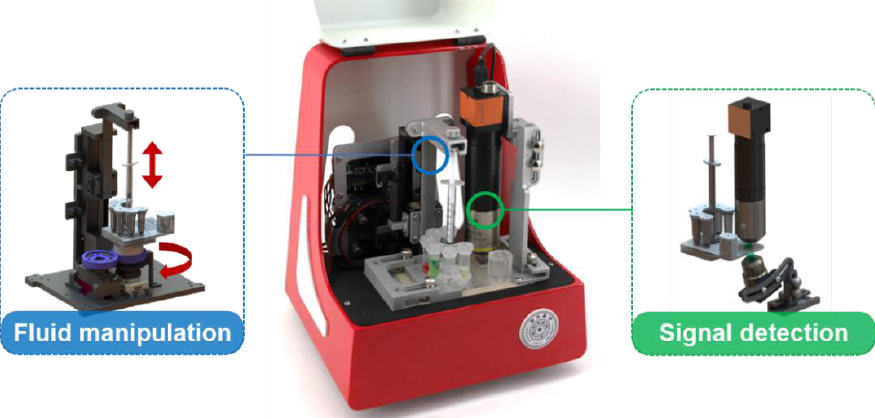
Figure 2. The completed prototype of the supporting device with fluid manipulation and signal detection modules.